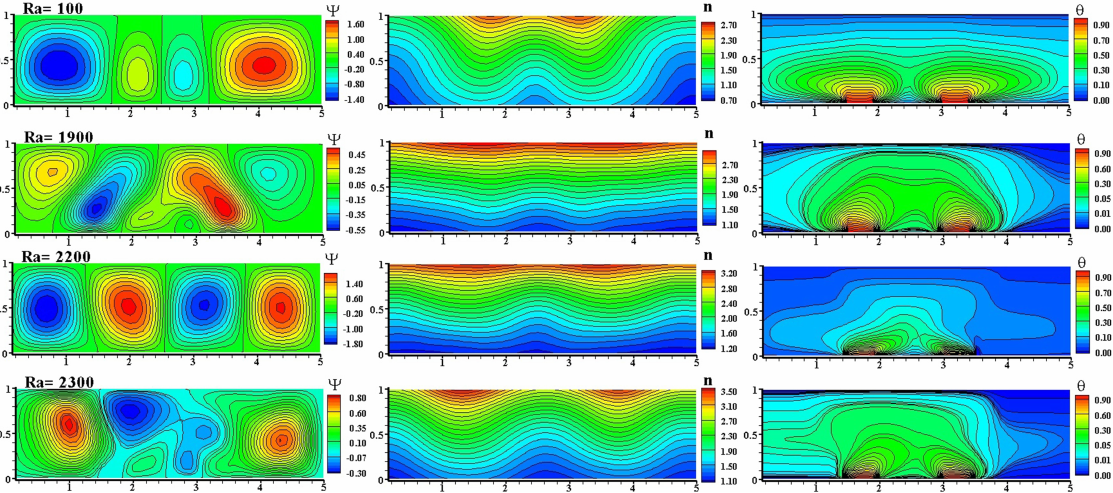
Figure 9. Case 7. From left to right, streamlines, microorganisms concentration and dimensionless temperature contours. For Sc = 1, Pe = 1, Ra T = 1708 and bioconvective Ra for 100, 1900, 2200 and 2300.